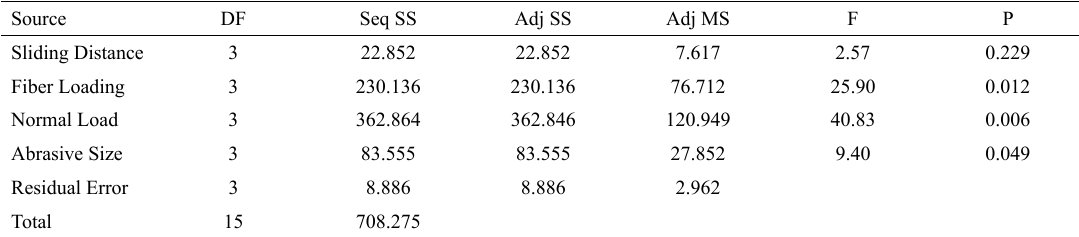
Table 6. ANOVA for specific wear rate of alkali treated jute fiber–epoxy composites Source